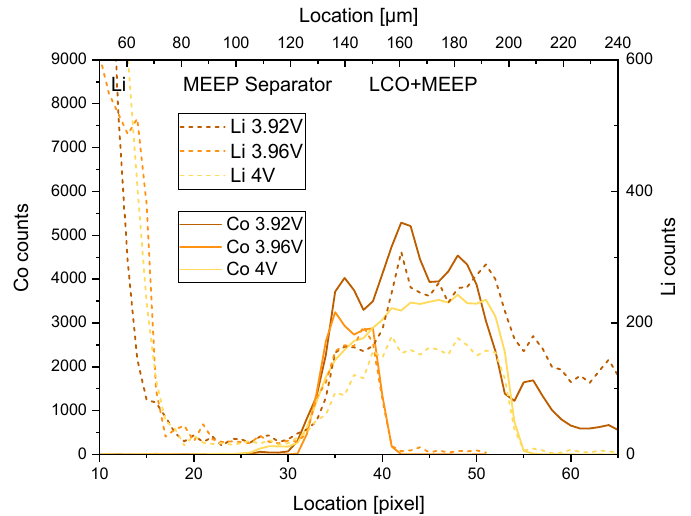
Figure 5. 1-D profiles of the MEEP-based ex-situ cells. The cells show strong differences in the mixed-cathode width, indicated by the LCO concentration and most likely due to the manufacturing or cross sectioning process. The ratios of Li to Co indicate a loss of approx. 20 at% Li in particular when comparing the 3.96 V and 4 V samples.